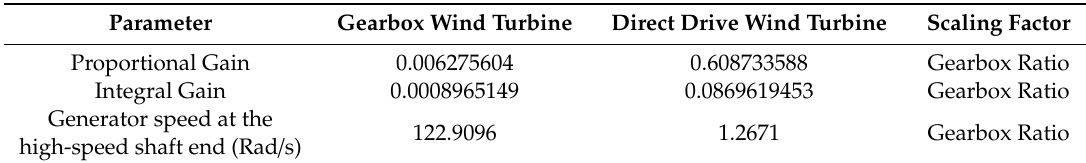
Table 1. Blade pitch control parameter modifications [39,41].